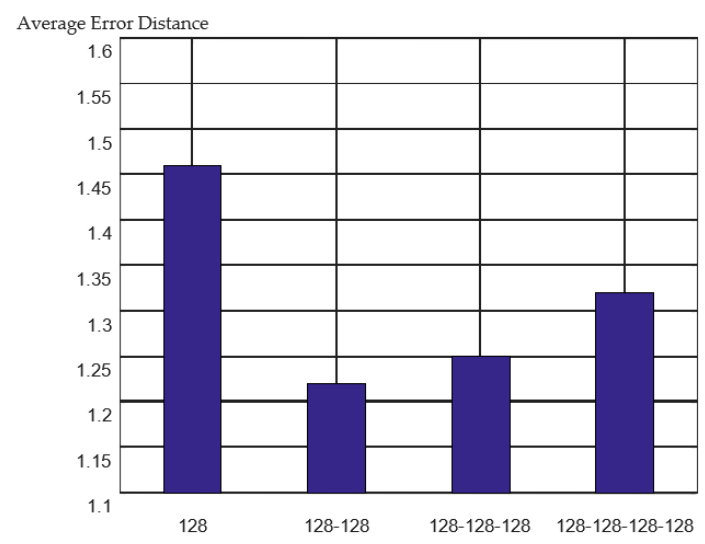
Figure 10. Localization effect of different DNN structures.